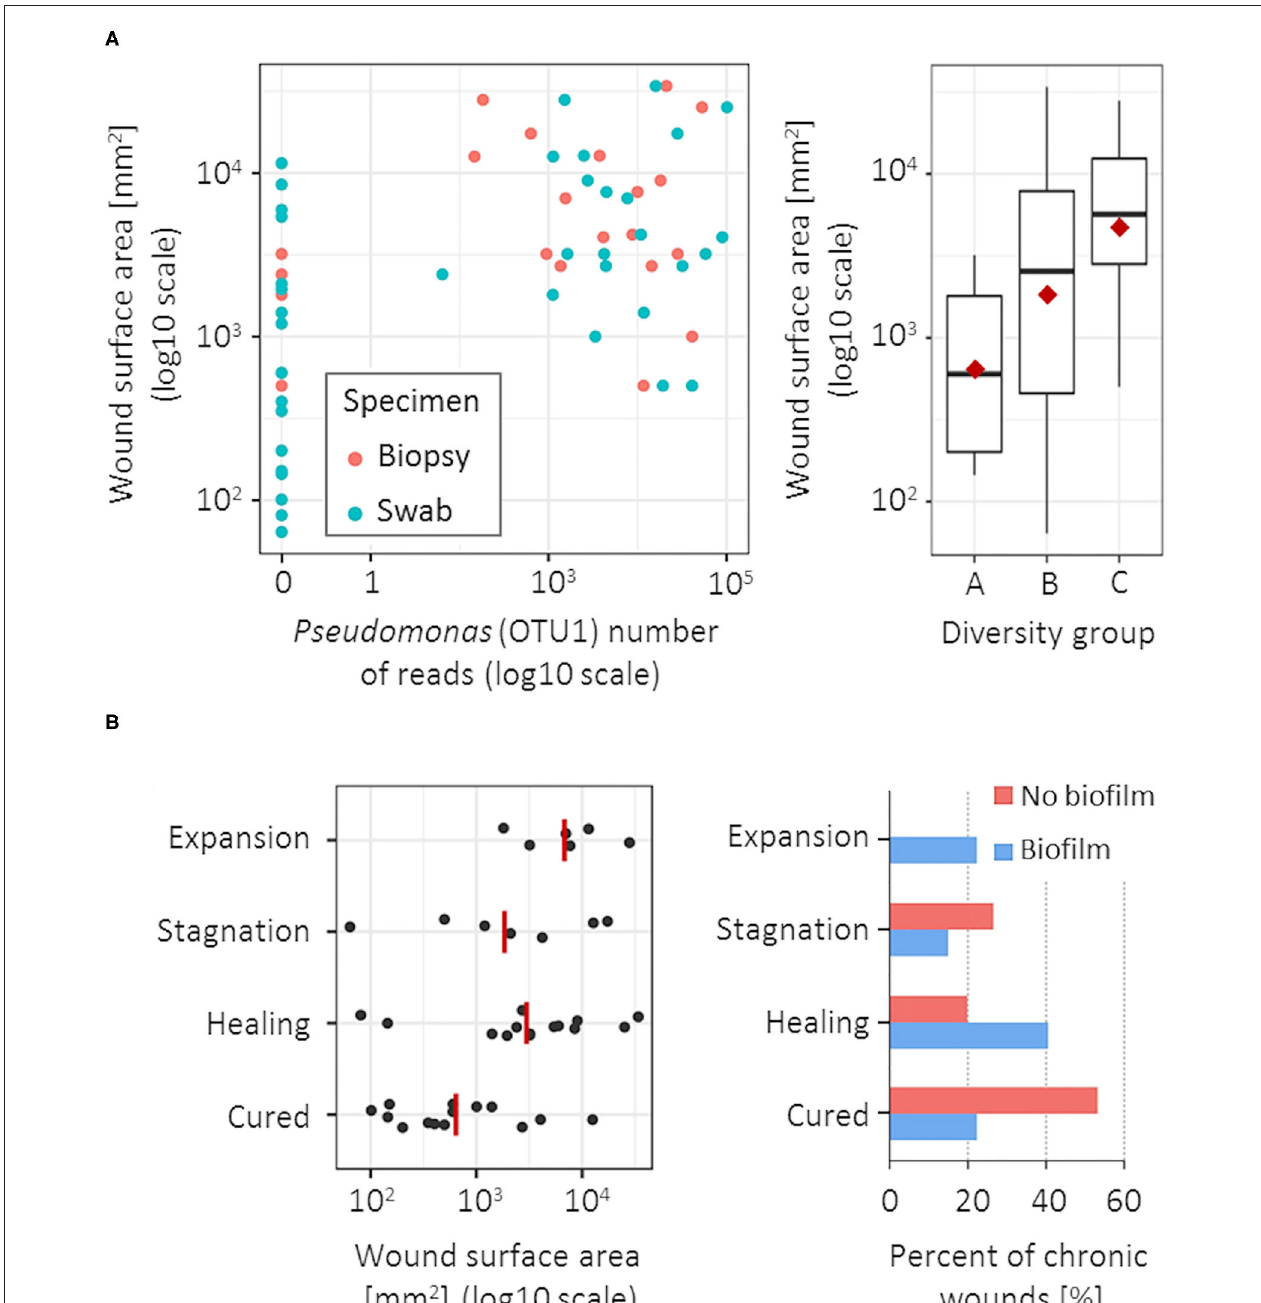
FIGURE 3 | Microbiota association with wound surface area at the time of sampling and clinical outcome at 1-year follow-up. (A) CW surface area was positively correlated with the Pseudomonas (OTU1) abundance (left), significant for both biopsy (blue) and swab specimens (red); and with a larger diversity of the bacterial community, but only in swab specimens (right). (B) Unfavorable clinical outcomes were most significantly associated with a larger CW surface area (left) and the clinically estimated presence of biofilm (right). Red lines/points denote group means.